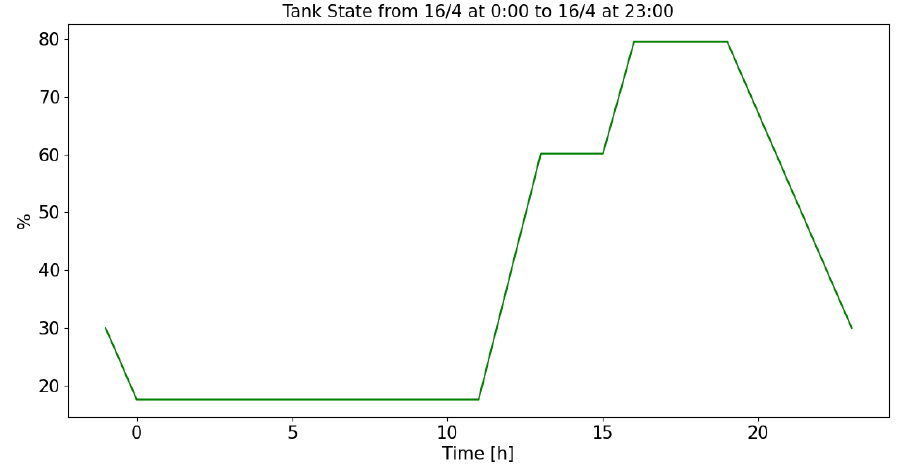
Figure 8. Percentage capacity of the hydrogen tank during the 24-h period.